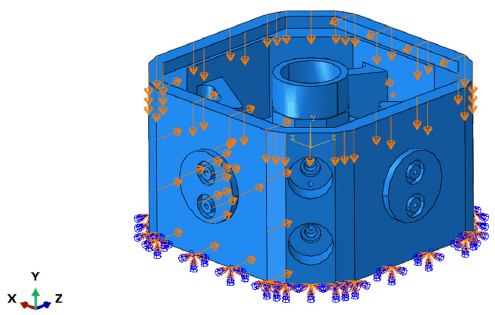
Figure 12. Structure diagram of the assembly block.